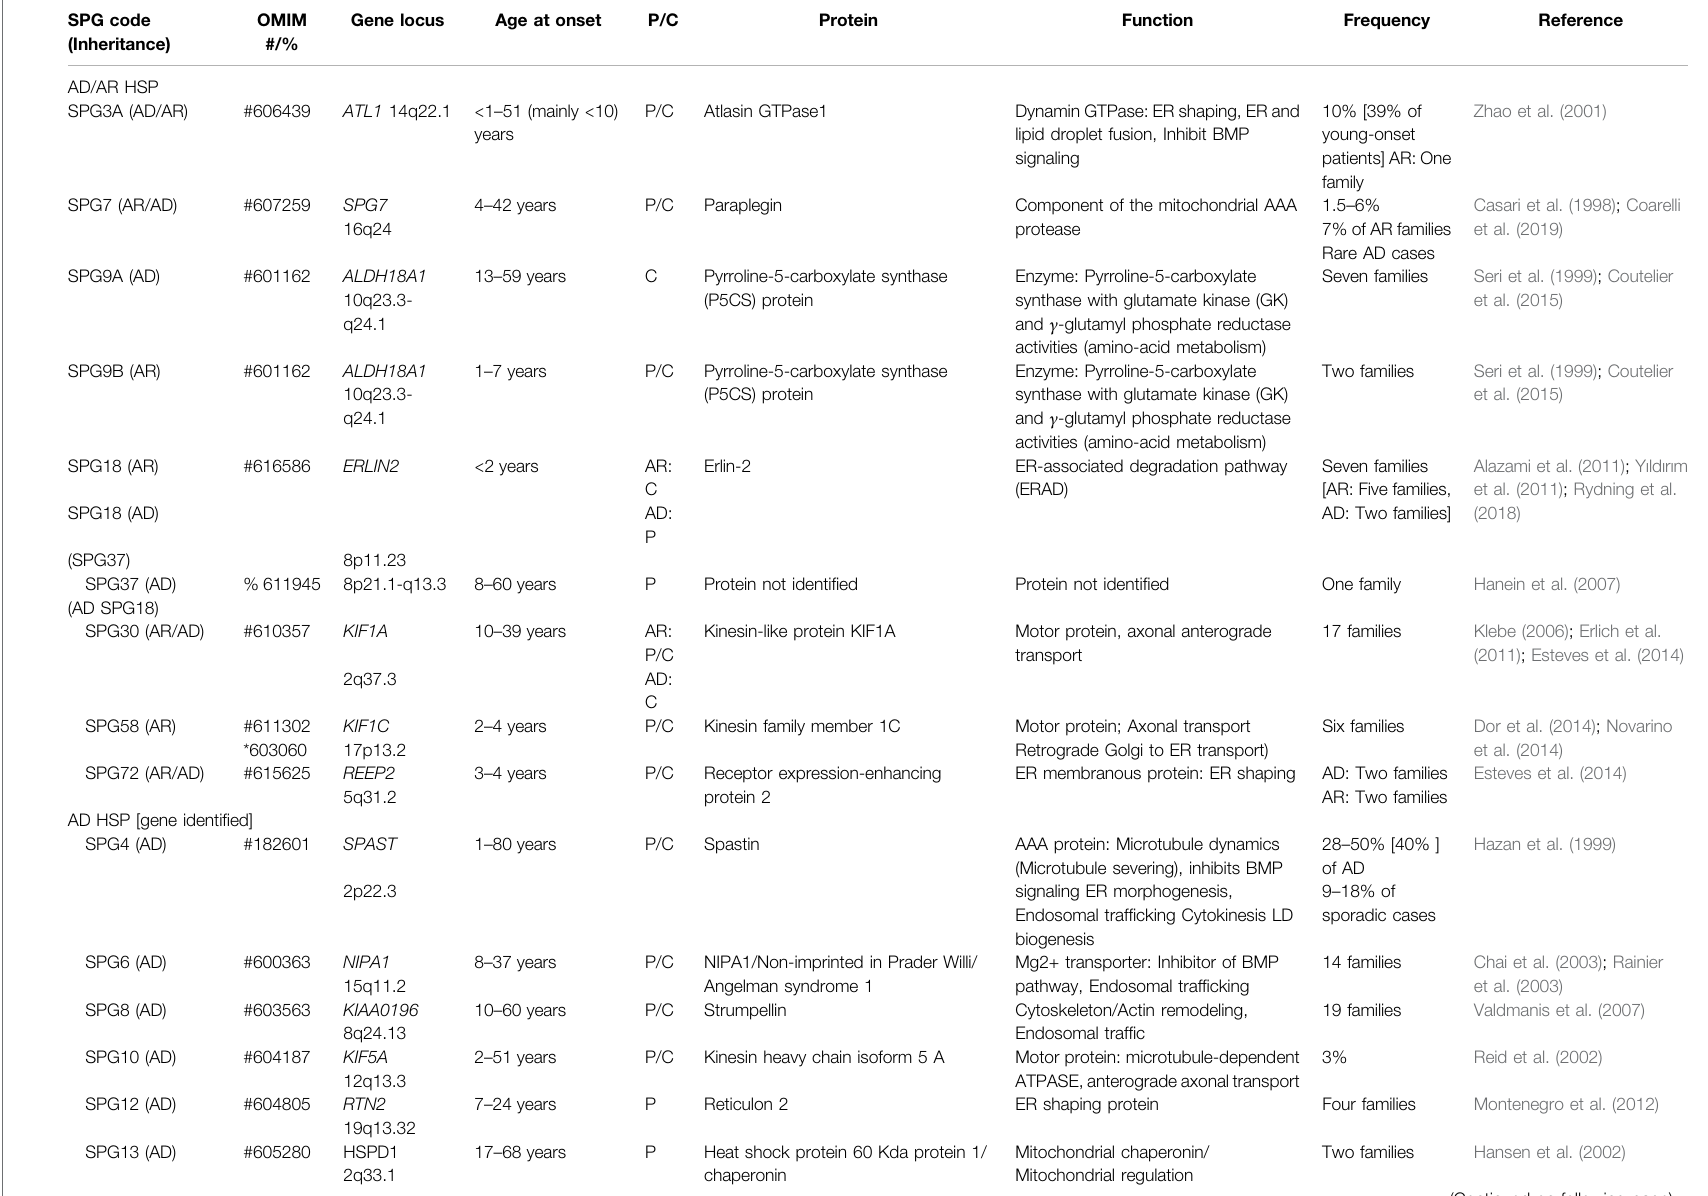
TABLE 3 | Table summarizing the 88 HSP clinical-genetic entities with special focus on the functions of their proteins and our suggested primary and secondary functional